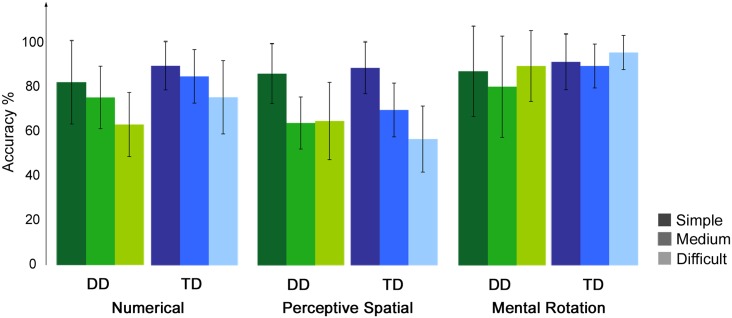
Behavioral results of the fMRI paradigm. Accuracies of the fMRI paradigm for each experimental condition split up for the three difficulty levels, the lighter the colors the more difficult the tasks.